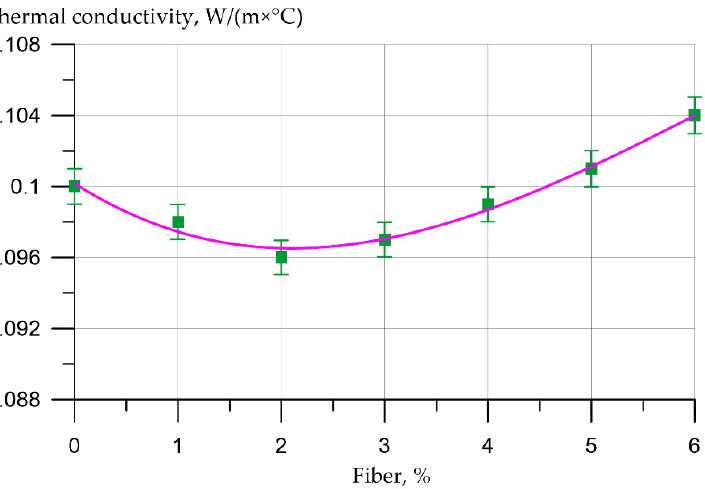
Figure 8. Results of experimental studies of the thermal conductivity of fiber foam concrete samples at various dosages of polypropylene fiber.